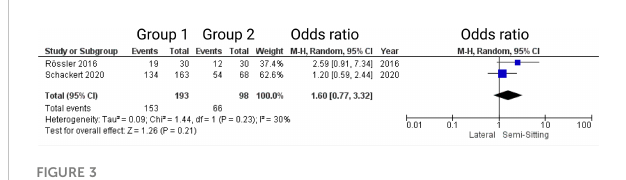
FIGURE 3 Forrest Plots displaying OR and 95% CI estimates for facial nerve outcome comparison between positioning group 1 (exclusively semi- sitting positioning) and positioning group 2 at 6 months